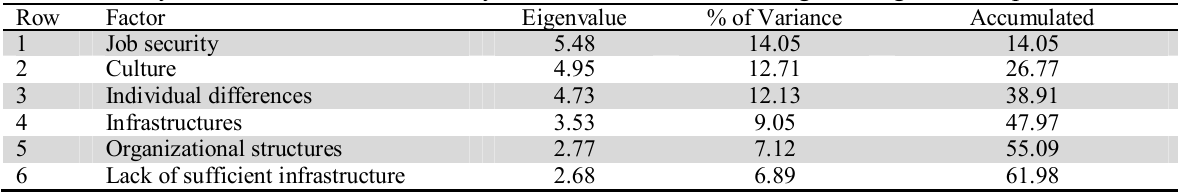
The summary of the results of factor analysis on barriers for knowledge management implementation